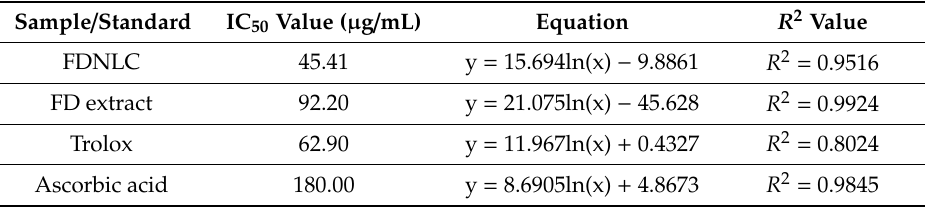
Figure 6. Percentage of DPPH inhibition by FDNLC and standards (Trolox and ascorbic acid). The experiment was done in triplicate ( n = 3). Table 2. IC 50 value of FDNLC sample, FD extract and standards used in the DPPH